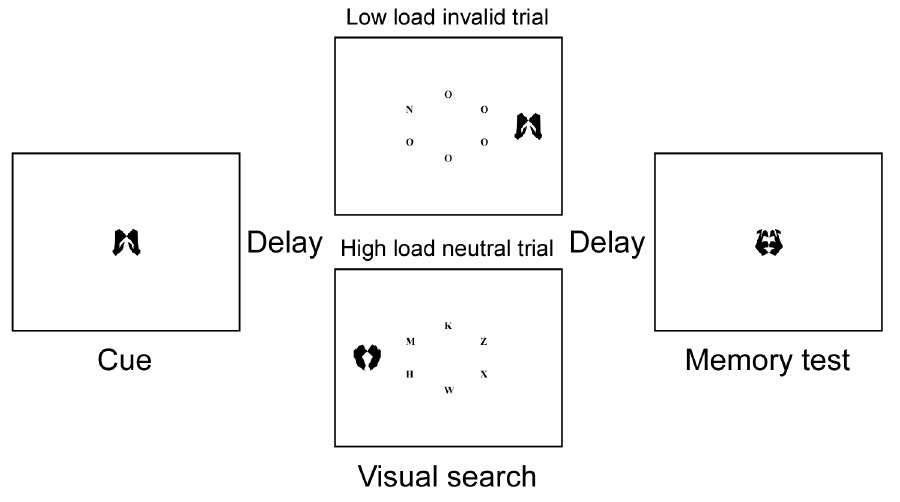
Fig 1. Examples of the different types of